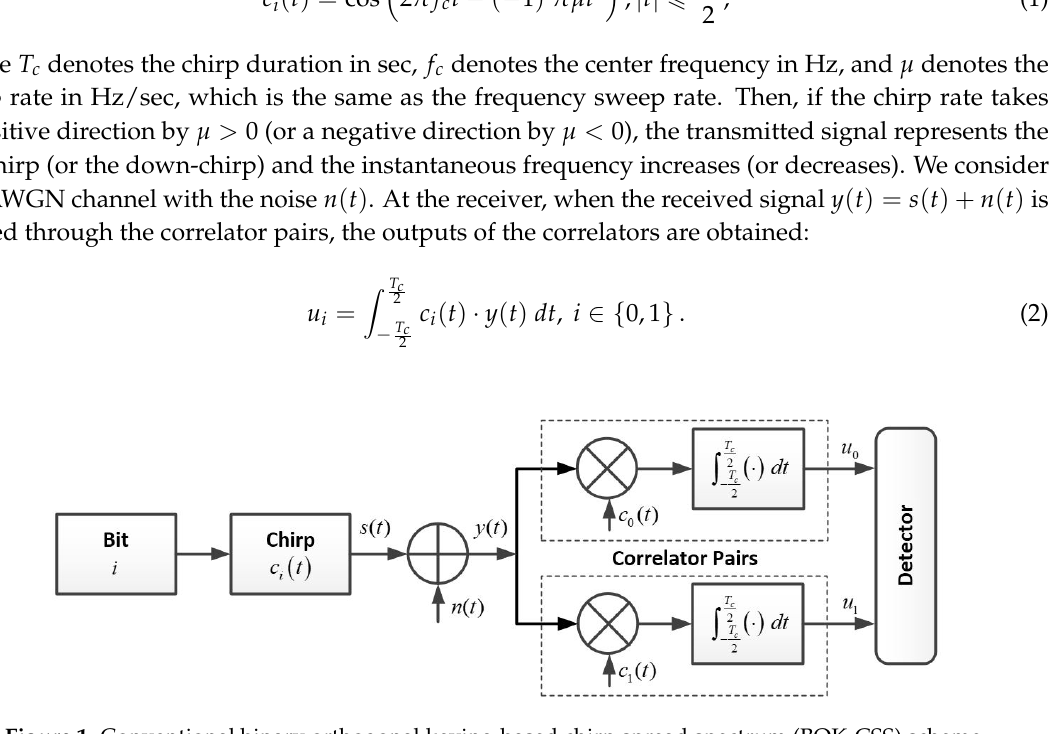
Figure 1. Conventional binary orthogonal keying-based chirp spread spectrum (BOK-CSS)